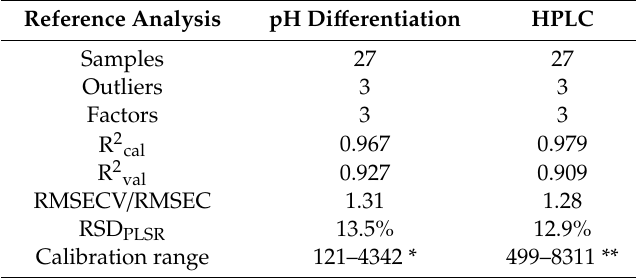
Table 5. Parameters of the established partial least squares regression PLSR